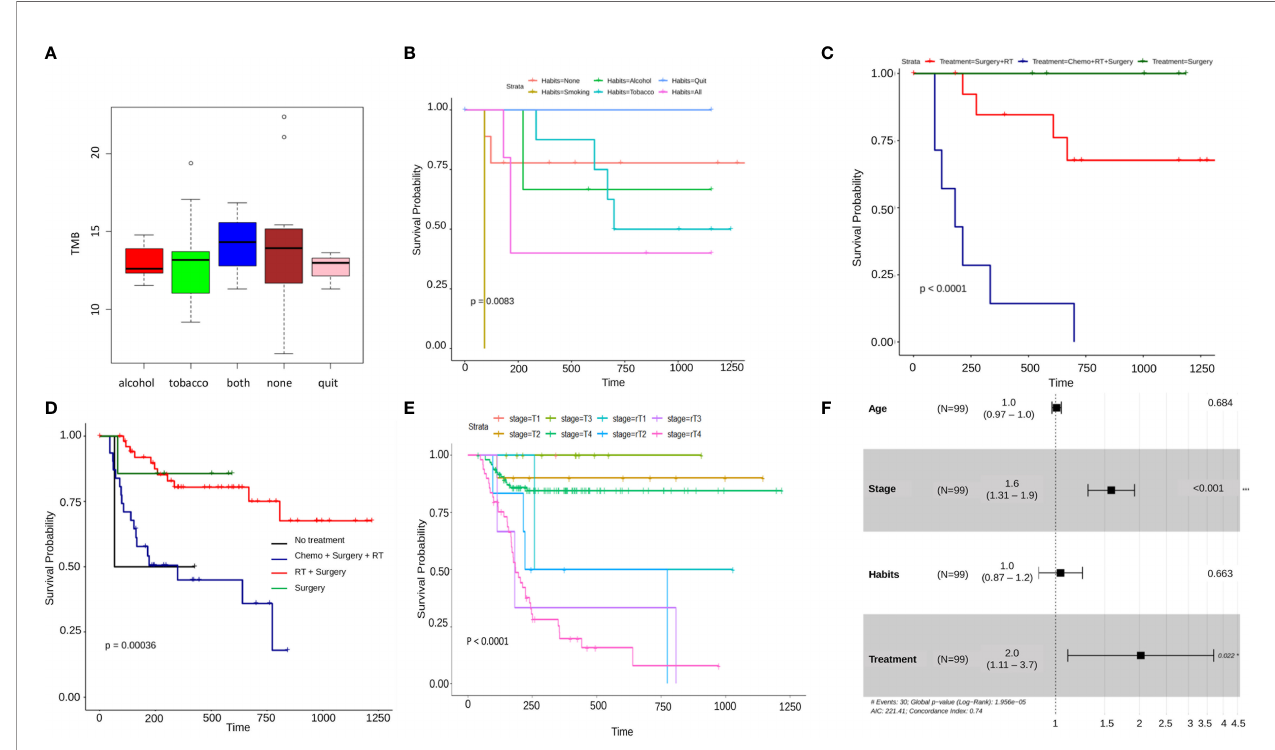
FIGURE 3 | (A) A boxplot of average tumor mutation burden of patients categorized by habits. Patients having both the habits of alcohol consumption and tobacco usage, show the highest amount of average tmb, lowest is seen to be in the patients with alcohol consumption and those who have quit either of the habits. Surprisingly, it is seen to be high in the patients having none of the habits. (B – E) Kaplam-Meier plots showing signi fi cant differential survival probabilities between different clinical categories. (B) This plot shows a signi fi cantly lower survival in patients with the habit of smoking as compared to any other category. (C) This Kaplan-Meier plot depicts a signi fi cantly lower survival probability in patients with a combined treatment regimen of chemotherapy, radiation therapy and Surgery as against any other individual or combined treatment type. This pattern gets re fl ected again in (D) where the data from ICGC Indian oral cancer cohort has been combined with in-house data and fi nally, (E) shows A differential survival plot of patients from ICGC and in-house data showing a signi fi cantly lower survival probability in patients with recurrent tumor stages as against their non-recurrent counterparts. (F) A cox-proportional hazard ratios forest plot, depicting the fact that there is a signi fi cant difference between various categories tumor stage and treatment